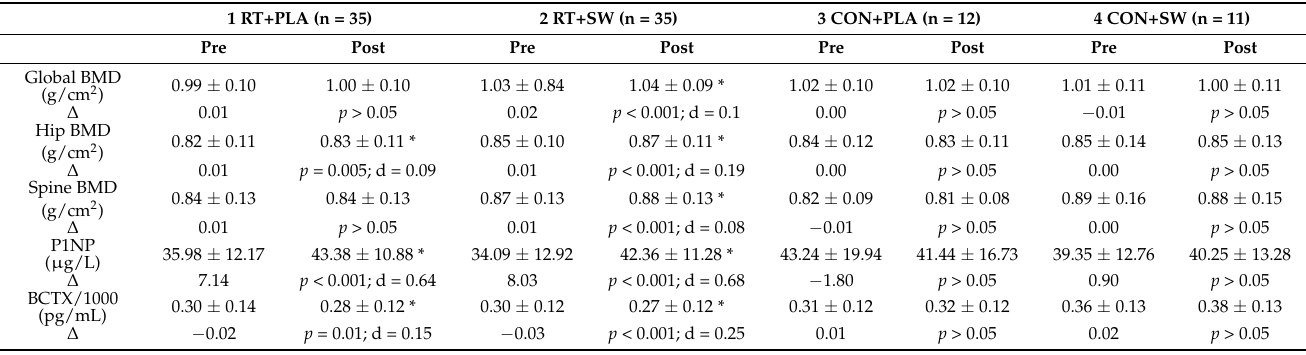
Table 5. Bone markers.